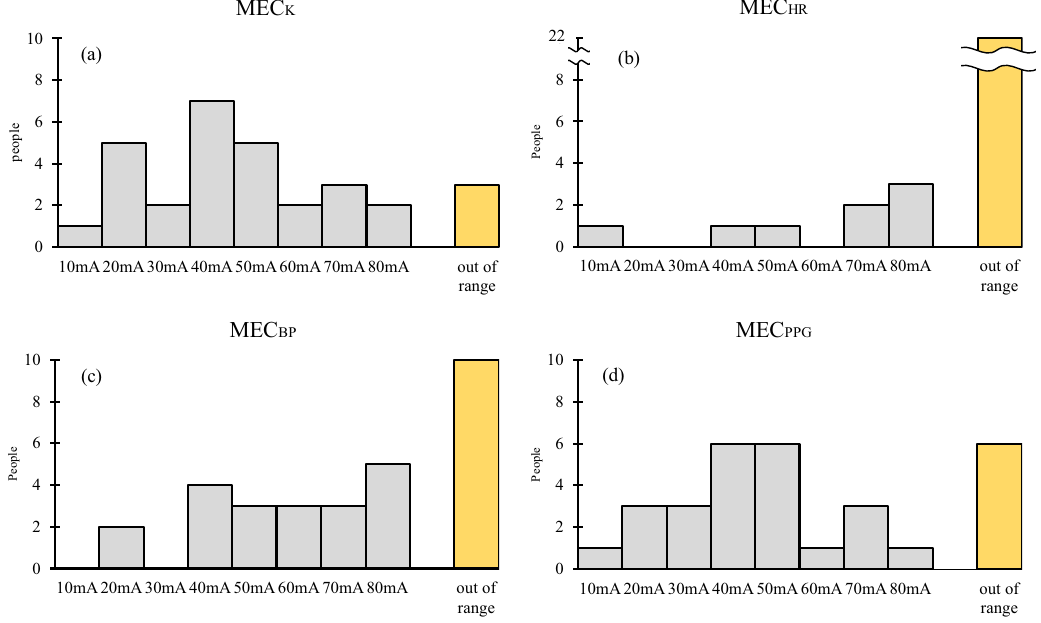
Figure 4. Histogram of each minimum evoked current (MEC). The distributions of MEC, vascular stiffness value (K), systolic blood pressure (BP), heart rate (HR), and photoplethysmography amplitude (PPG) are shown. MEC represents the minimum stimulus current intensity at which a change of more than 5% in the parameter appears for tetanus stimuli given in 10 mA increments. Except for HR, which was very often outside the measurement range, frequency peaks were generally around 40–50